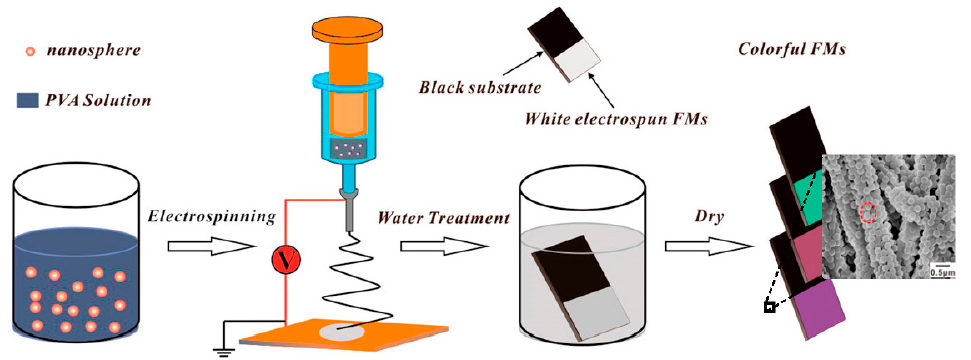
Figure 5. Schematic illustration of the fabrication process of electrospinning for preparation of colorful fibrous membranes. Reprinted with permission from [69] American Chemical Society, 2015.